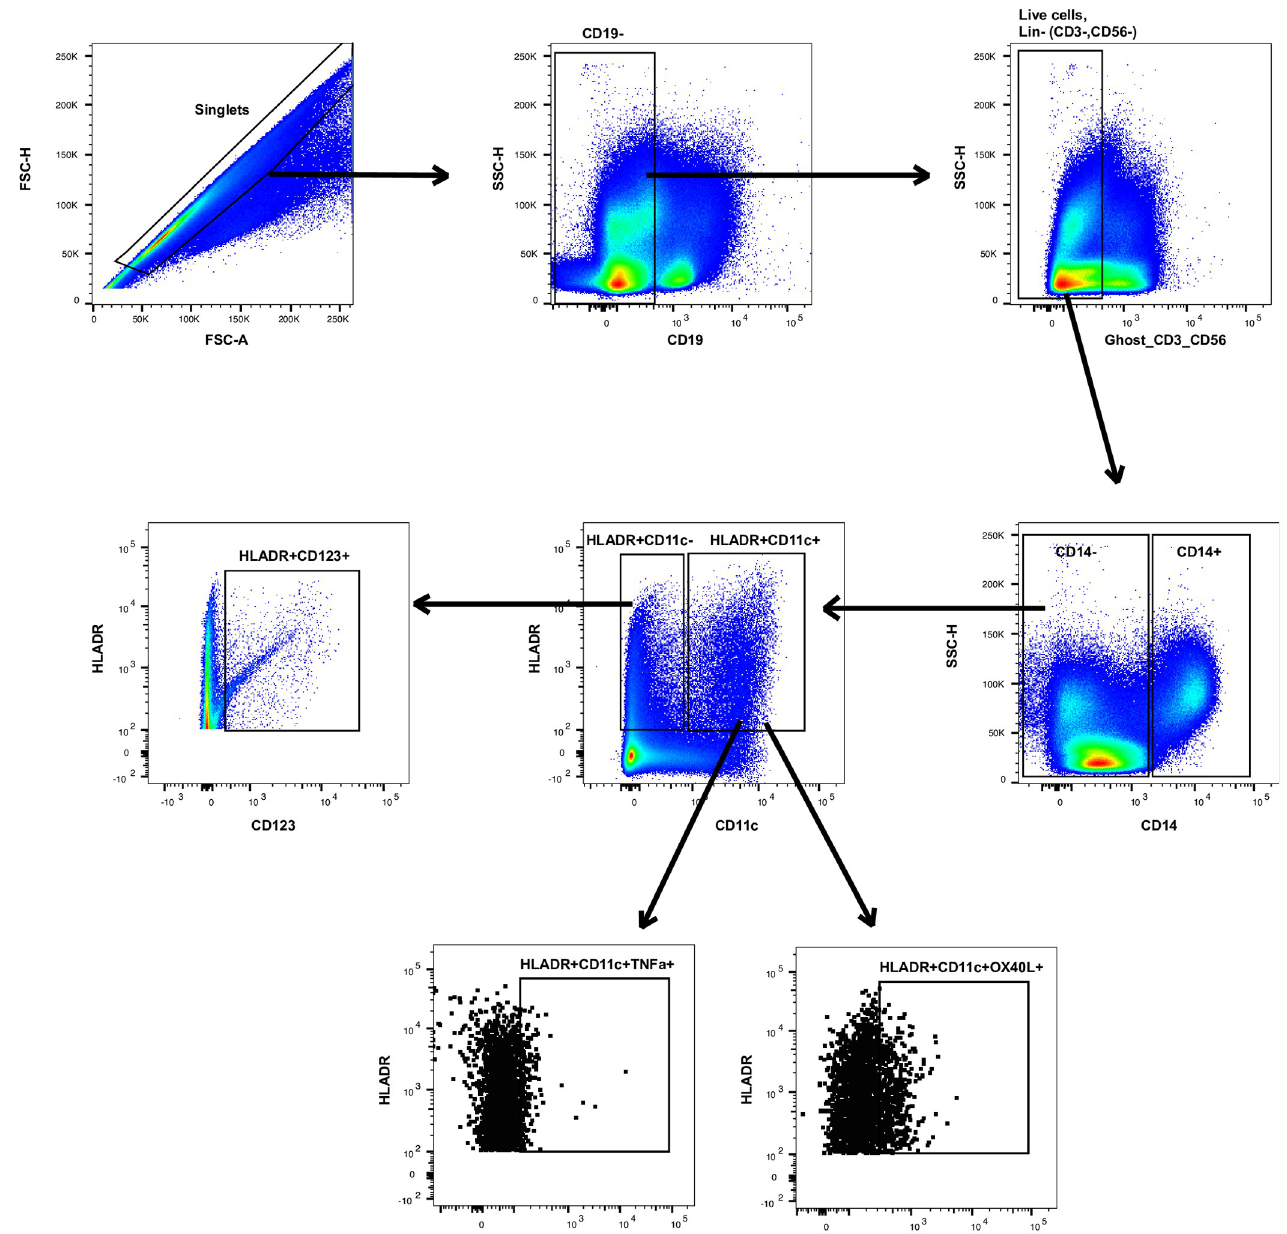
Fig 1. Gating strategy to identify dendritic cell subpopulations from PBMCs. For DC phenotyping, B-cell negative (CD19-), Live positive, and Lineage negative (CD3-CD56-) populations were selected. From the CD19-Live+CD3-CD56- parent population, monocytes were identified by CD14+ expression. From the non-monocyte (CD14-) parent gate, myeloid DCs (mDC) were defined by expression of HLADR+CD11c+. From the mDC parent gate, OX40L and TNFa were identified. From the CD14-HLADR+CD11c- parent gate, plasmacytoid DCs (pDCs) were defined by the expression of